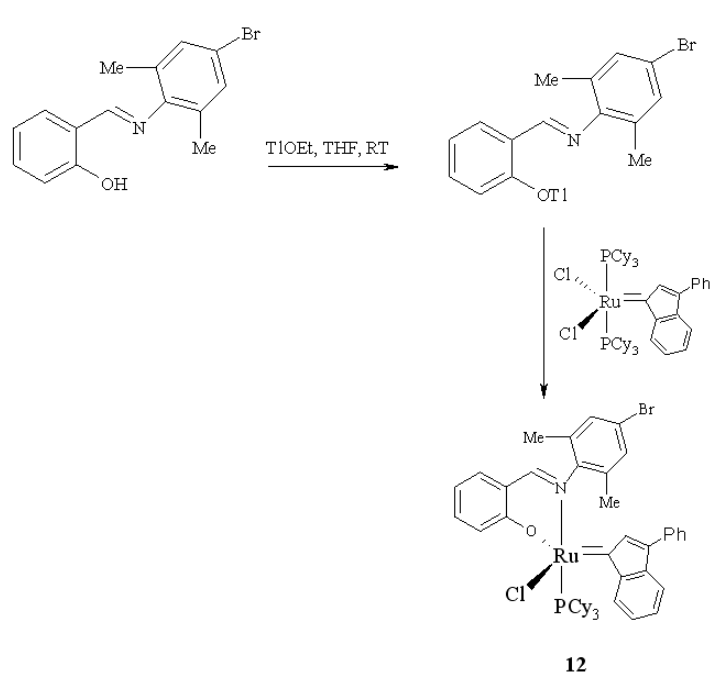
Scheme 8 Synthesis of Schiff base Ru-indenylidene complex 12